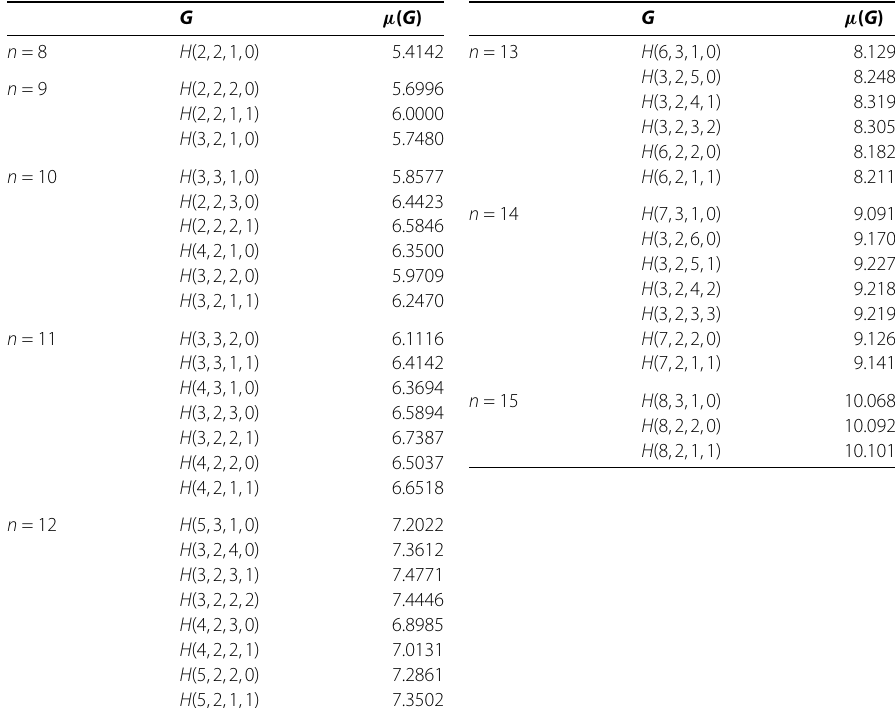
Table 1 The Laplacian spectral radii of some Halin graphs with three interior vertices G μ ( G ) n = 8 H